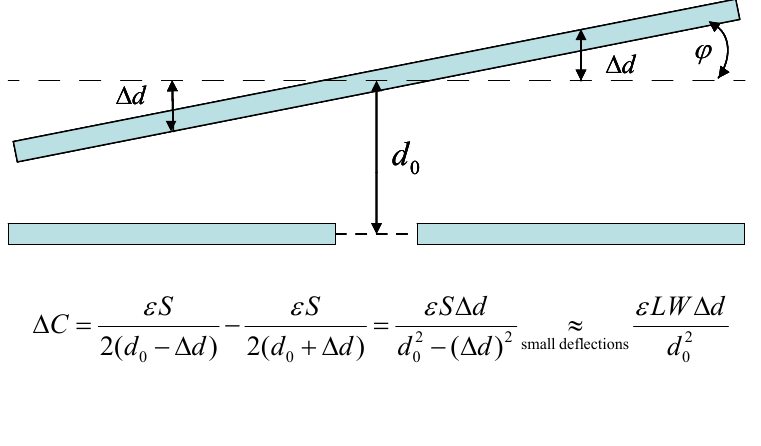
Figure 7. Differential change of the two sensing